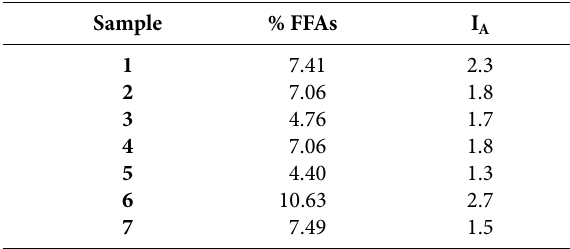
Table 3. The integral values of signals relating to FFA α-methylene groups and their measured I A values. Sample